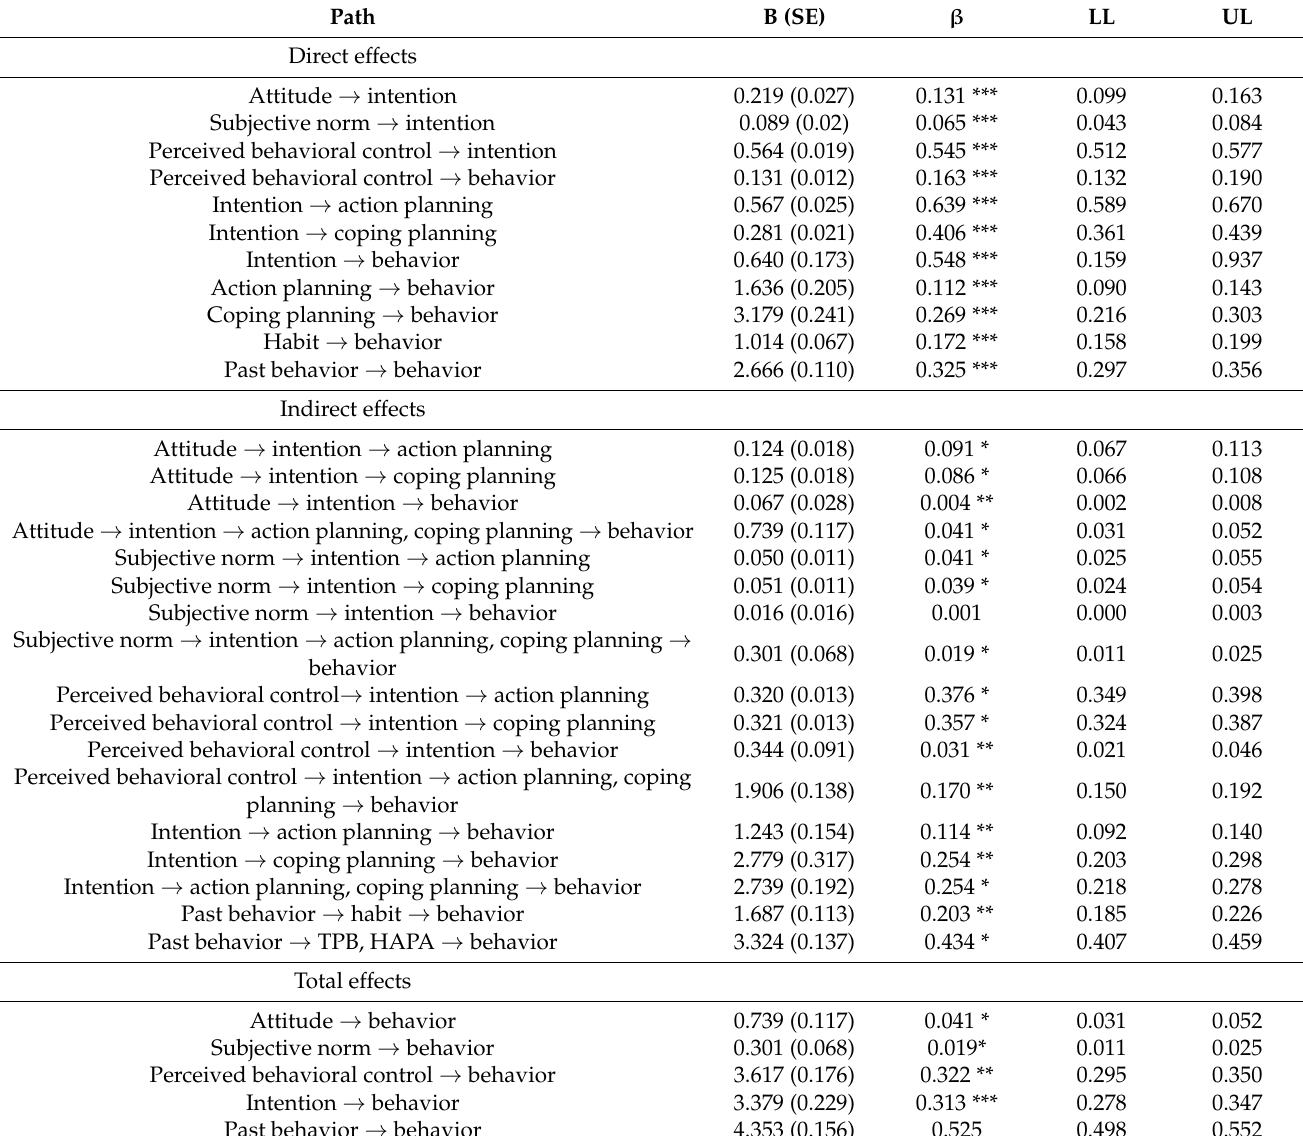
Table 4. Direct, Indirect, and Total Effects in the Proposed Model Predicting Green Purchase